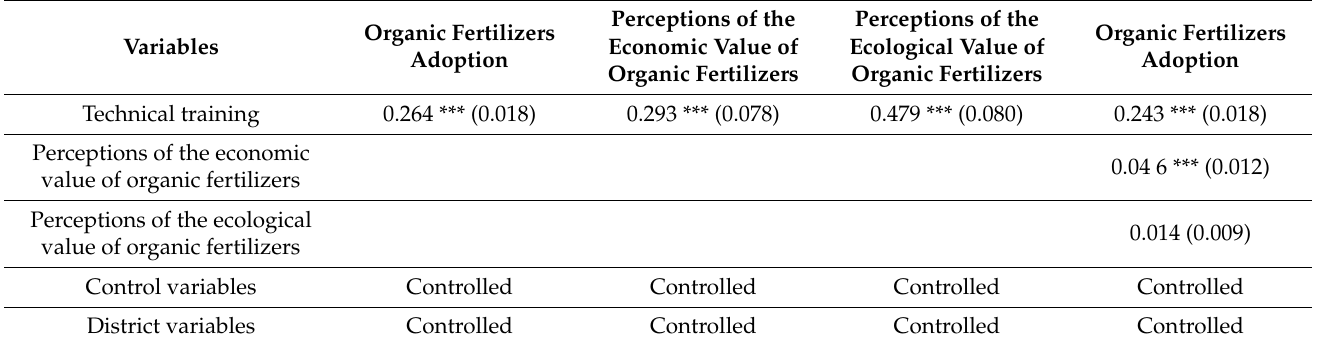
Table 7. Mediating effect results of farmers’ perception of organic fertilizer.